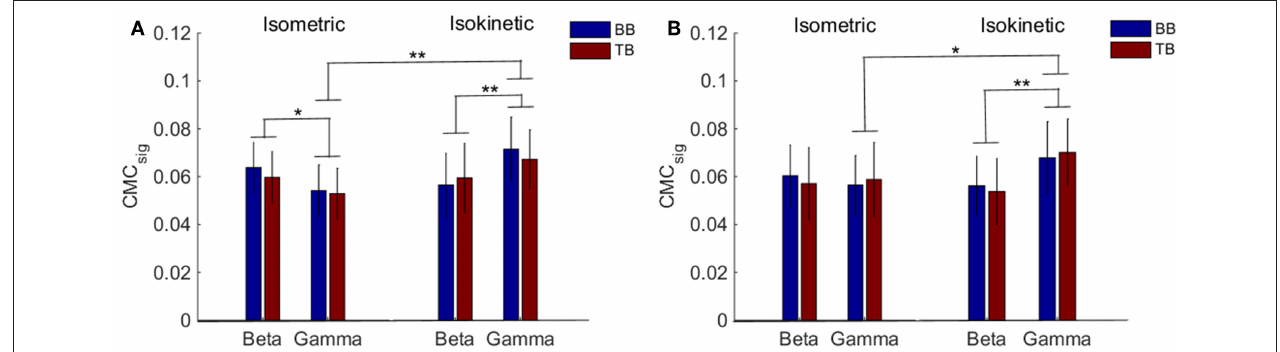
FIGURE 5 | Grand average of the CMC sig values between EEG signal from C1 and C5 and EMG signal from the BB and TB muscle during isometric exercise and isokinetic movement in the beta- and gamma-range, respectively. (A,B) show the CMC sig values under C1 and C5 electrodes, respectively. We denoted the significance with the star mark. * p < 0.05 and ** p < 0.01. Error bars show the standard error of the